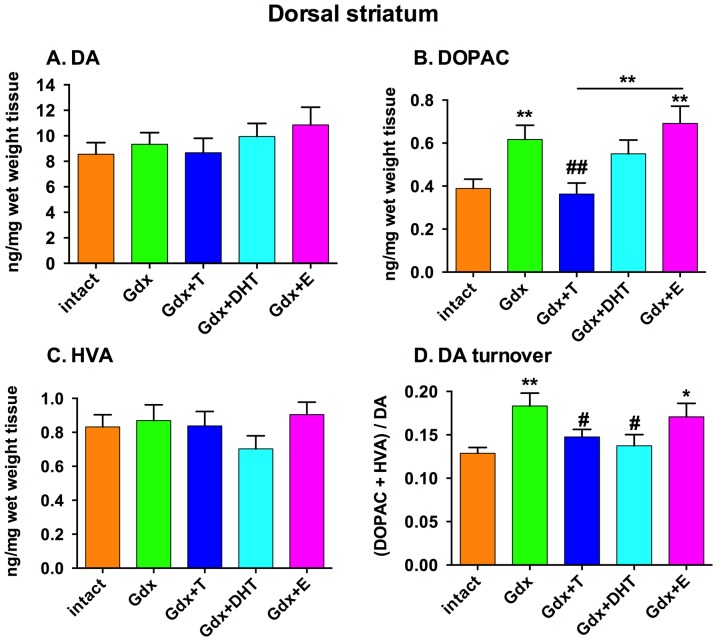
The effect of gonadectomy and sex steroid replacement on dopamine, dopamine metabolites and dopamine turnover in the dorsal striatum of adolescent male rats.There was no significant effect of treatment group on dopamine (A) or HVA (C). Gonadectomy increased DOPAC (B) and this increase was attenuated by testosterone replacement only. Dopamine turnover (D) was significantly increased by gonadectomy and this was attenuated by testosterone and DHT replacement but not 17β-estradiol replacement. * denotes comparison with Intact unless comparison indicated by a line, # denotes comparison with the Gdx group, * and # p<0.05; ** and ## p<0.01, n = 11–16/group for all.